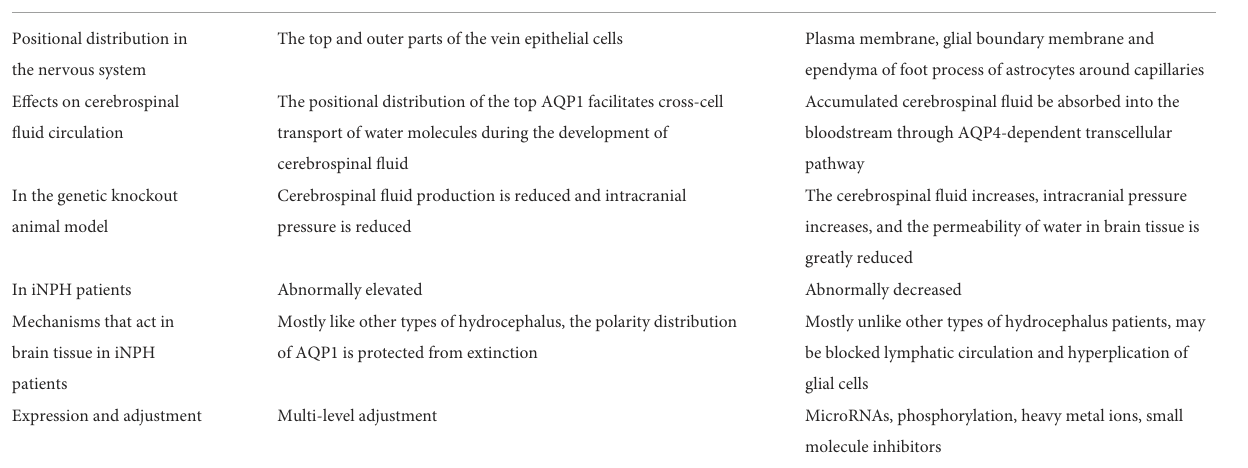
TABLE 2 AQP1 and AQP4 in